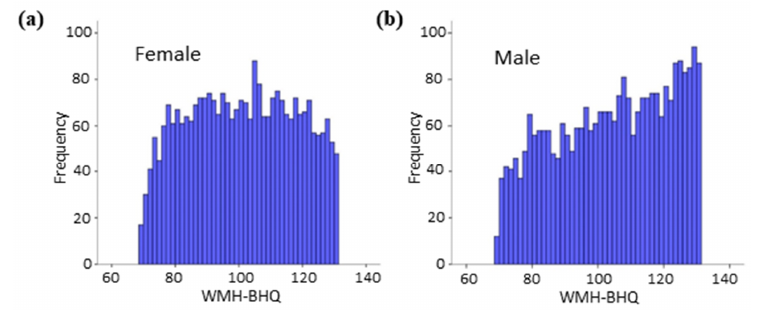
Figure 2. WMH-BHQ Histograms of females ( a ) and males ( b ). Table 3. Mann-Whitney U test of white matter hyperintensity brain healthcare quotient (WMH-BHQ) without medical history according to genders and age decades.